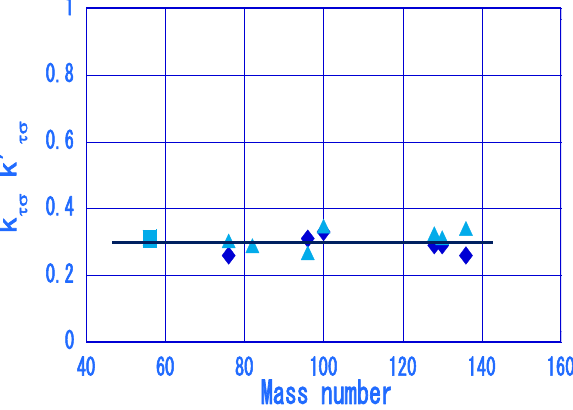
Figure 3. Reduction coefficients for axial-vector NMEs. Light blue triangles: k τσ (SD) for the QP SD states by SCERs on DBD nuclei. Blue diamonds: k (cid:48) τσ (SD) for low-ling SD states by SCERs on DBD nuclei. Light blue square: ( k τσ (GTSD)) 1/2 for the QP GT-SD states by DCER on 56 Fe. Solid line: the reduction coefficient of 0.3 to guide